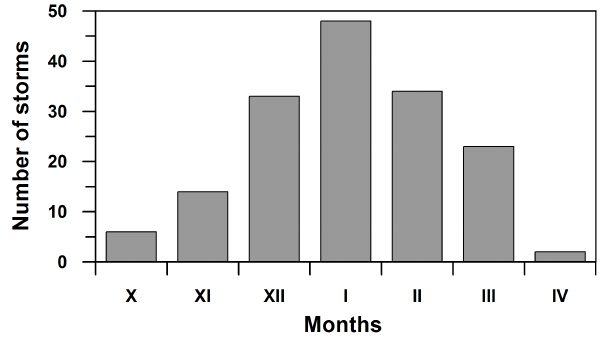
Fig. 3. Monthly distribution of the selected storms for